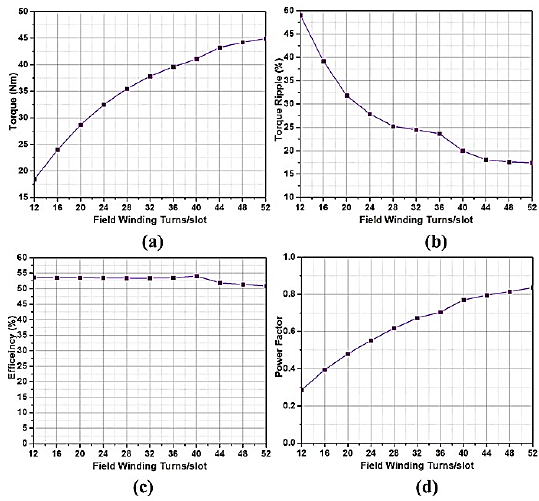
Figure 7. Effect of variation of field winding turns on machine performance ( a ) torque; ( b ) torque ripple; ( c ) efficiency; and ( d ) power factor.